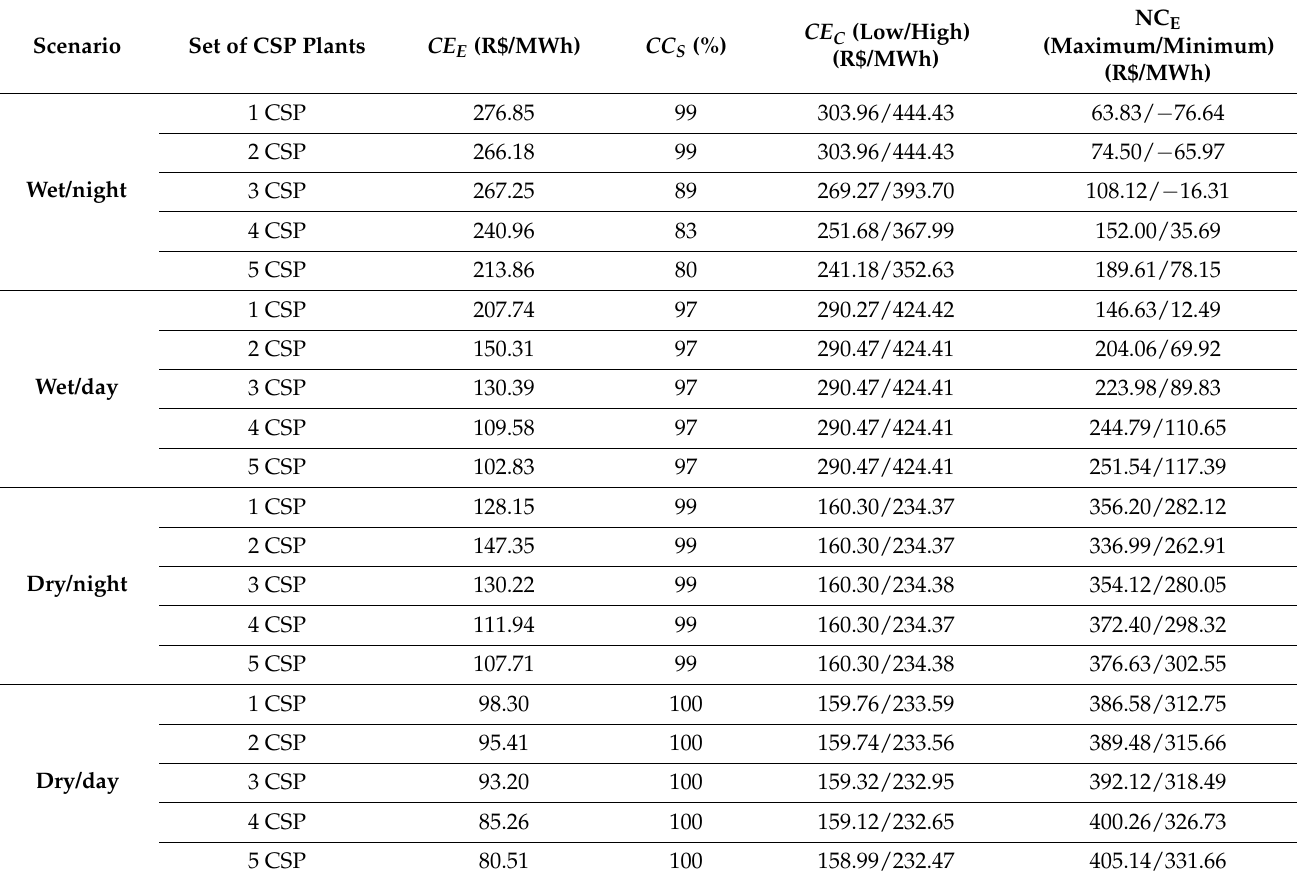
Table 7. Economic benefits and the net cost of sets of CSP plants in the hydrothermal system.